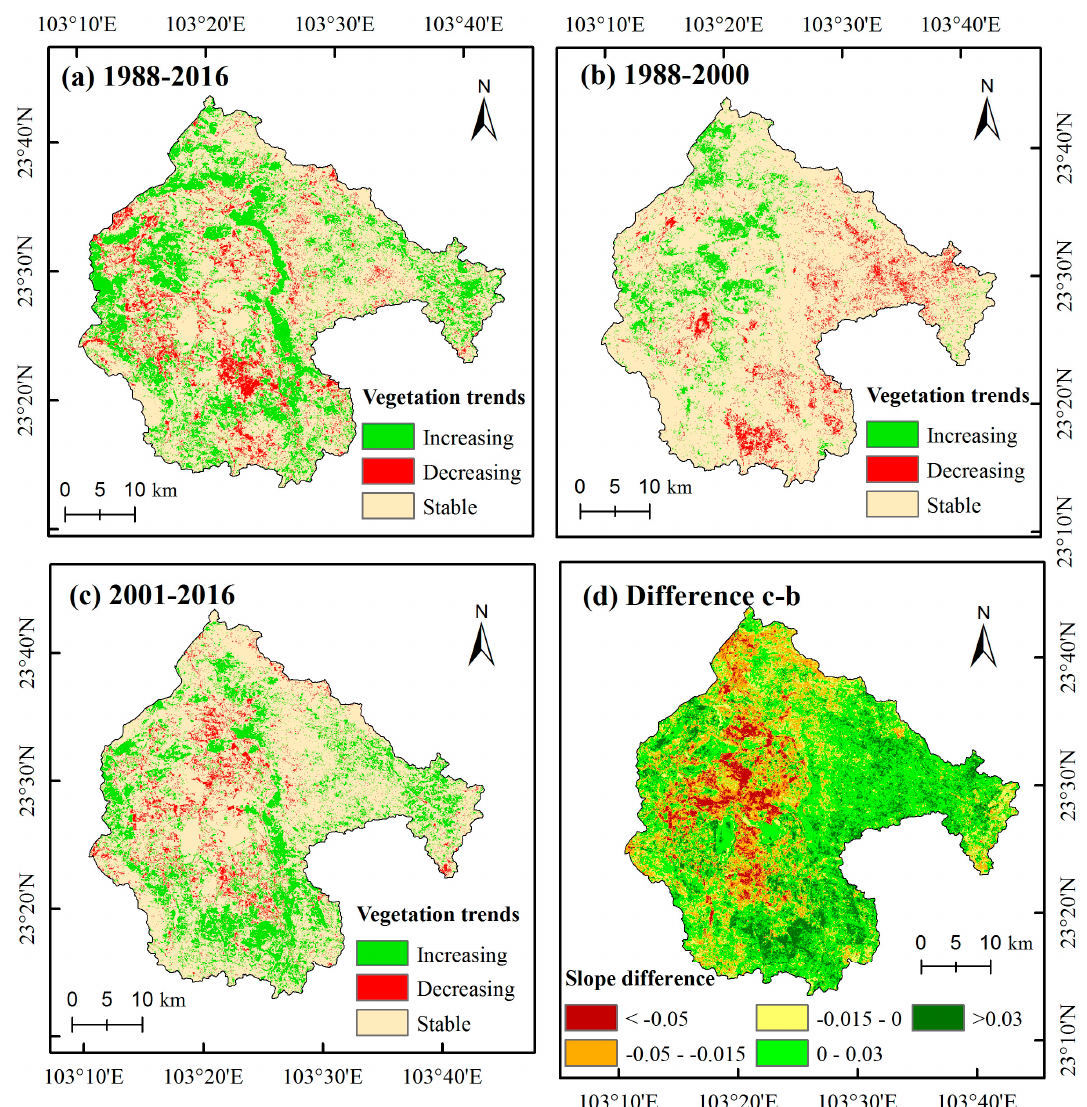
Figure 6. The spatial distribution of vegetation trends for di ff erent periods in the Nandong watershed: ( a ) Full time series (1988–2016); ( b ) reference period (1988–2000); ( c ) conservation period (2001–2016); and ( d ) vegetation trend slope di ff erence between the conservation period (2001–2016) and reference period (1988–2000).